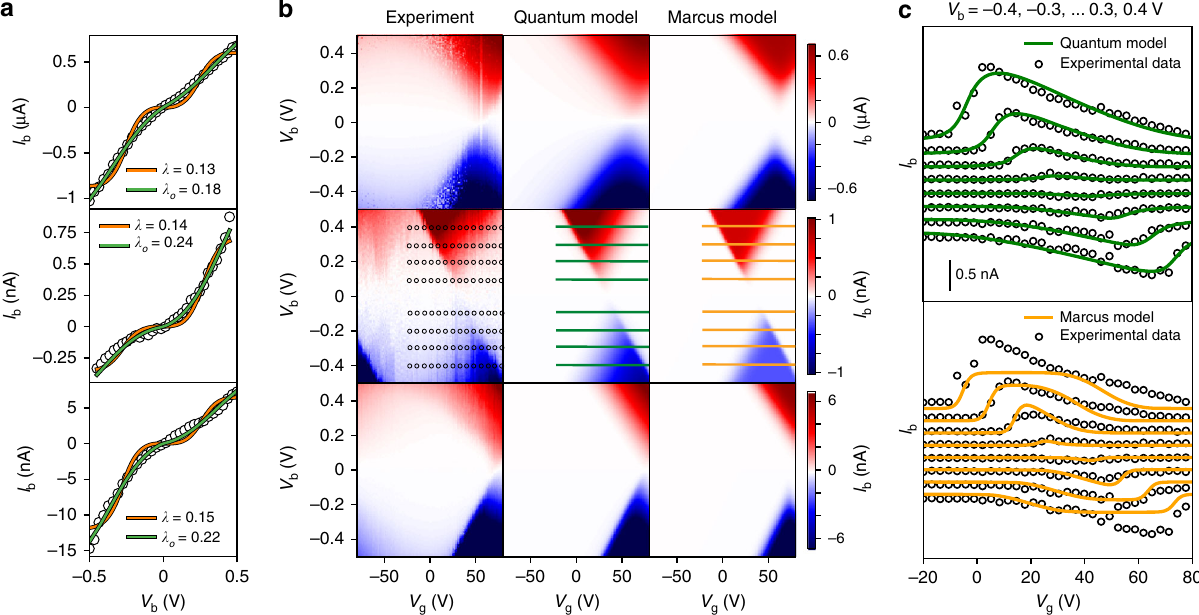
Fig. 5 Investigation of devices B – D at 77 K. a IV traces at resonance of 3 devices (B, C, D) of molecule M on SiO 2 dielectric at 77 K (data from ref. 22 ) and the fi t to the Marcus model (orange) and the quantum model (green). For clarity, fewer experimental data points were shown. b Charge stability diagrams of the same 3 devices as in c, and the reconstructed stability diagrams from the fi ts in c according the quantum model, or the Marcus model. c Gate traces ( I b vs. V g ) at multiple values of V b (indicated by horizontal lines in b)) for device C to compare experimental data and fi ts to the quantum model (upper panel, green) and Marcus model (lower panel, orange). I b values for consecutive gate traces are offset by 0.2 nA for clarity. Gate trace comparisons for devices B and D are displayed in Supplementary Note